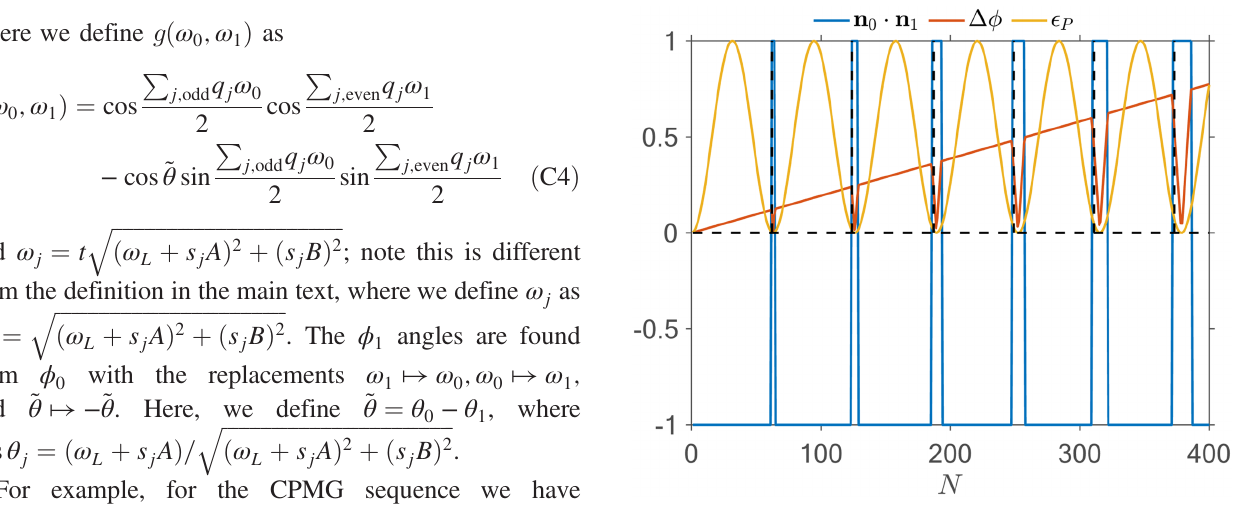
FIG. 11. Jumps in the dot product of nuclear spin rotation axes for UDD 4 as a function of N occur in the ranges when Δ ϕ → 0 ; Δ ϕ is defined as j ϕ − ϕ 0 1 j . In these ranges, the entangling power ϵ is zero. For this simulation, we set P ð ω L ; A; B Þ ¼ 2 π · ð 314 ; 60 ; 30 Þ kHz, unit time of t ¼ 3 . 1861 μ s, and we consider a spin S ¼ 1 = 2 electron